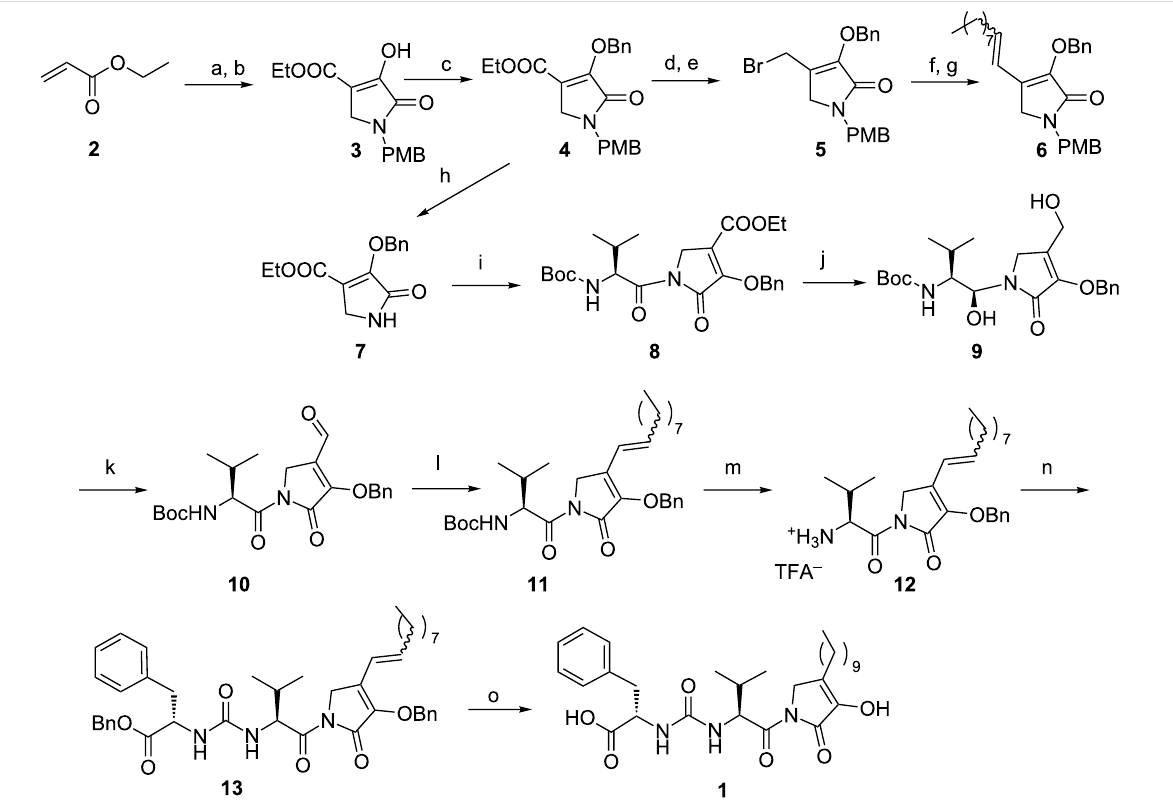
metabolites and show a number of biological activities, i.e., antibacterial, antiviral, antifungal and anticancer. More than one hundred of them have been isolated from a variety of natural sources